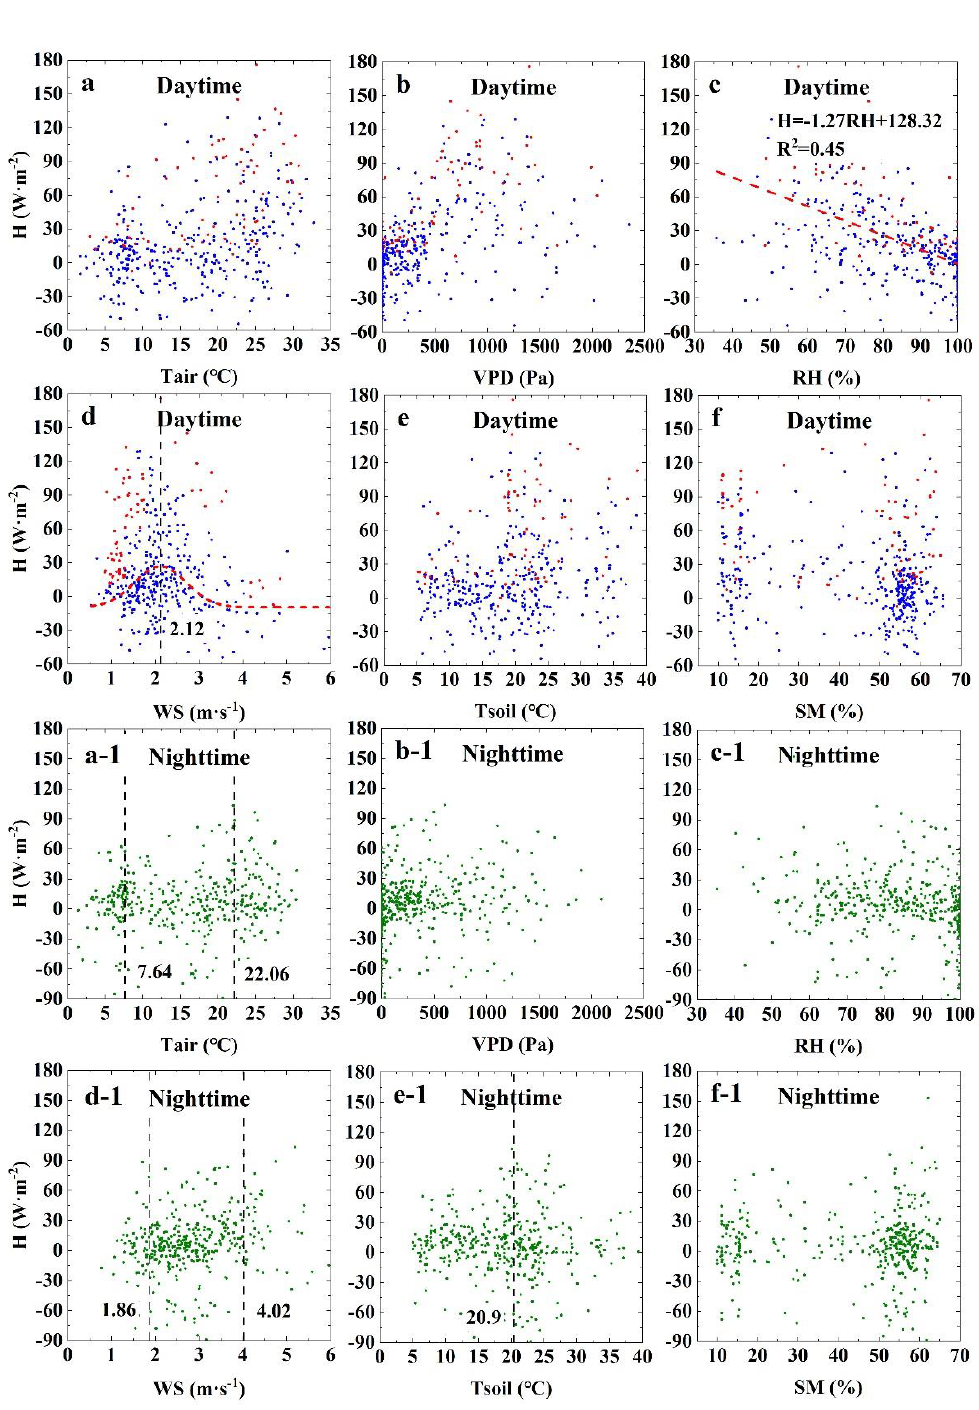
Figure 10. Relationships between H and the environmental factors in the alternation of day and night. ( a – f ) Relationship between environmental factors and H in daytime: ( a ) Tair represents air temperature, ( b ) VPD represents vapor pressure deficit, ( c ) RH represents relative humidity, ( d ) WS represents wind speed, ( e ) Tsoil represents soil temperature, ( f ) SM represents soil moisture. ( a-1 – f-1 ) Relationship between environmental factors and H in nighttime. H represents sensible heat flux, ( a-1 ) Tair represents air temperature, ( b-1 ) VPD represents vapor pressure deficit, ( c-1 ) RH represents relative humidity, ( d-1 ) WS represents wind speed, ( e-1 ) Tsoil represents soil temperature, ( f-1 ) SM represents soil moisture.